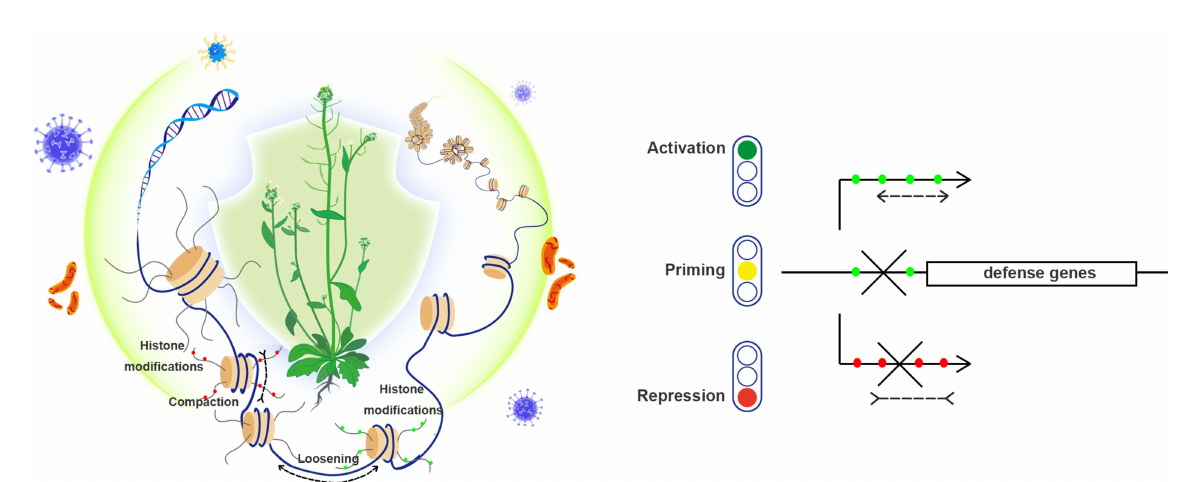
FIGURE 1 Both histone modification and chromatin remodeling are implicated in plant resistance to pathogens. (Left) Plant nucleosomes are widely subjected to various histone modifications, including repressive histone methylation (such as H3K27me3, labeled as red dots) and permissive histone methylation and acetylation (such as H3K4me3 and H3K14ac, labeled as green dots). Chromatin remodeling includes nucleosome sliding (compaction or loosening of neighboring nucleosomes) and histone variant exchanges. These epigenetic changes coordinate to shape local chromatin, which act as important mechanisms underlying transcriptional reprogramming, and effectively contribute to plant resistance (illustrated by an Arabidopsis plant under protection) to diverse pathogens (virus, bacteria and fungi). (Right) Different transcriptional states of defense genes are illustrated by: gene activation (green light) that is often associated with permissive histone modifications (green dots) and loosened chromatin structure, priming state (yellow light) where permissive histone modifications can also be found but transcription is poised yet uninitiated, and gene repression (red light) that is generally accompanied with repressive histone modifications (red dots) and compacted chromatin